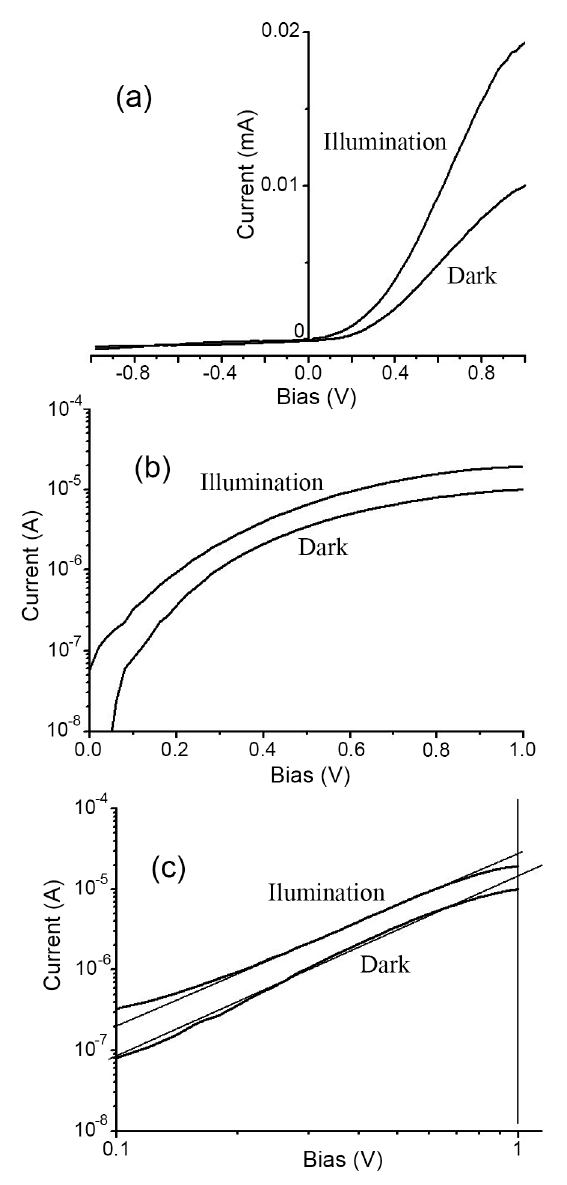
Figure 9: Current–voltage characteristics in dark and under UV illumi- nation for a p-Si/n - Zn 0.9 Mg 0.1 O heterostructure plotted on linear (a), semi-logarithmic (b) and double logarithmic coordinates (c).